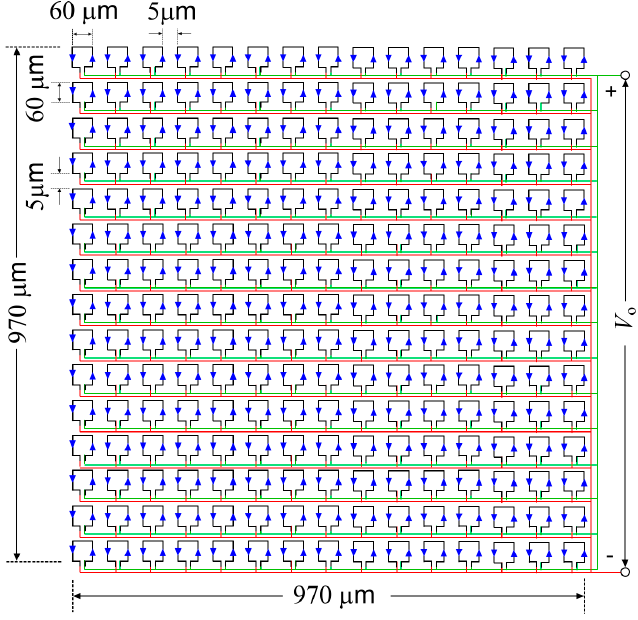
Figure 7. 15×15 crossed parallel sub ‐ loop inductors. Figure 7. 15 × 15 crossed parallel sub-loop